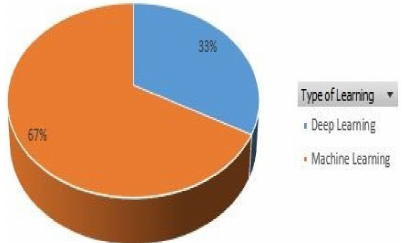
Figure 13. Deep Learning vs. Machine